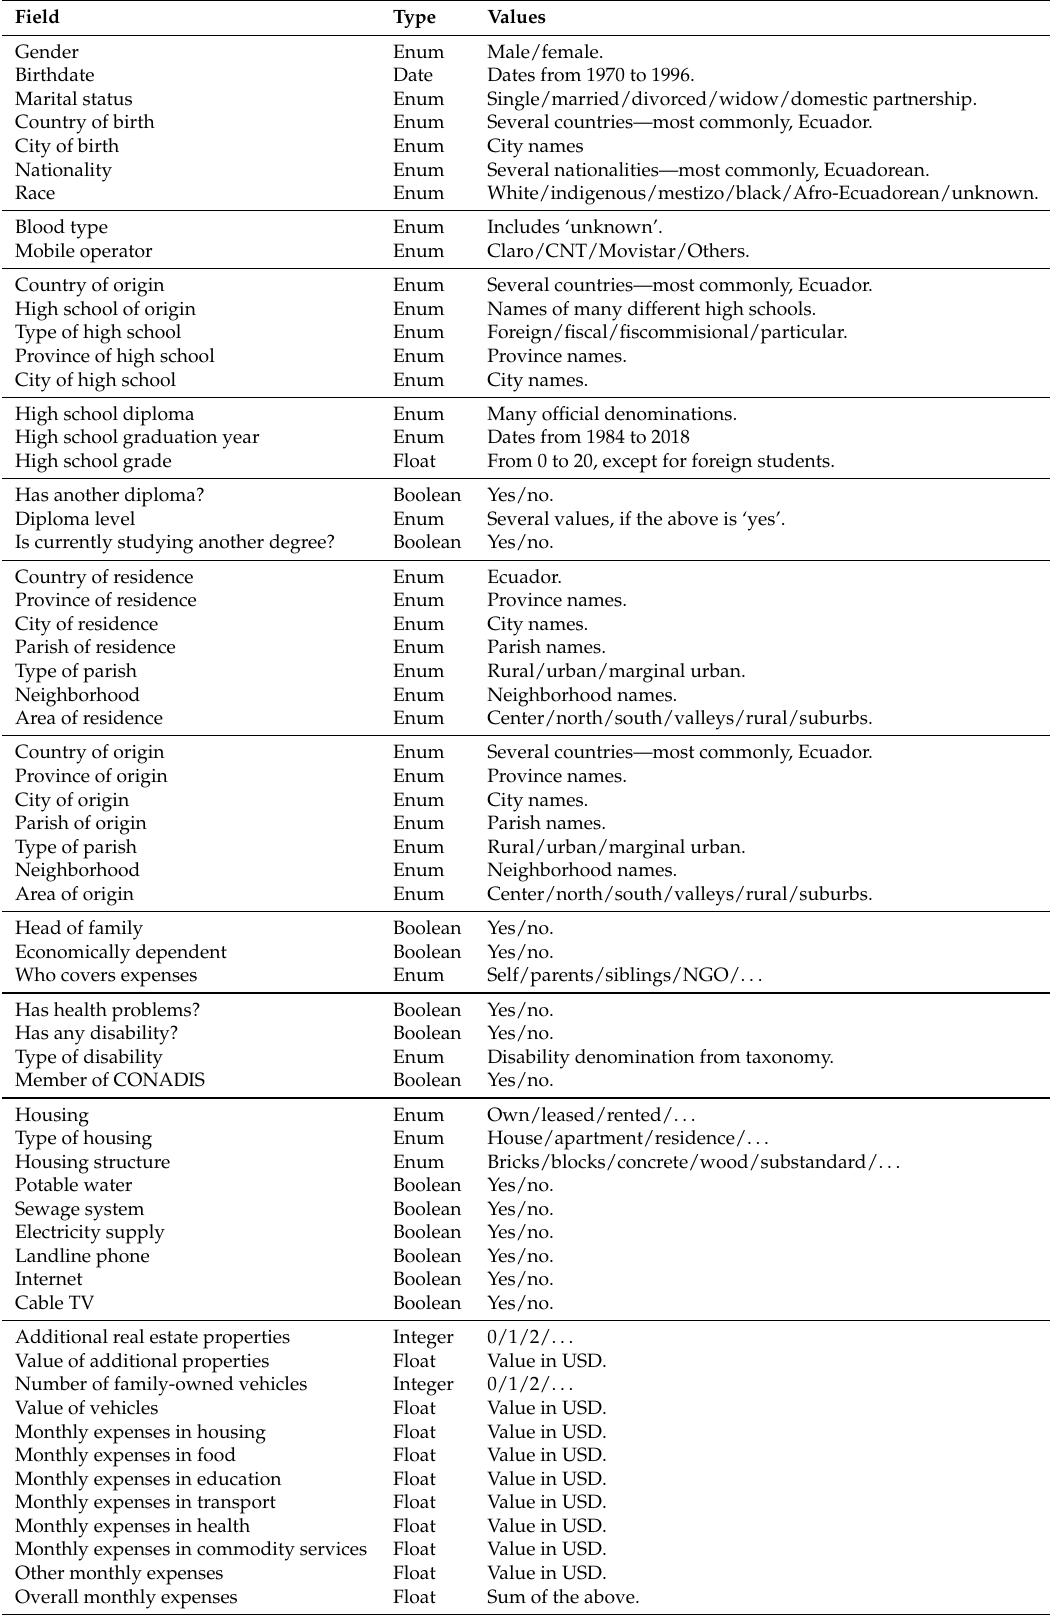
Table 1. The data fields captured in the Universidad Politécnica Salesiana (UPS)